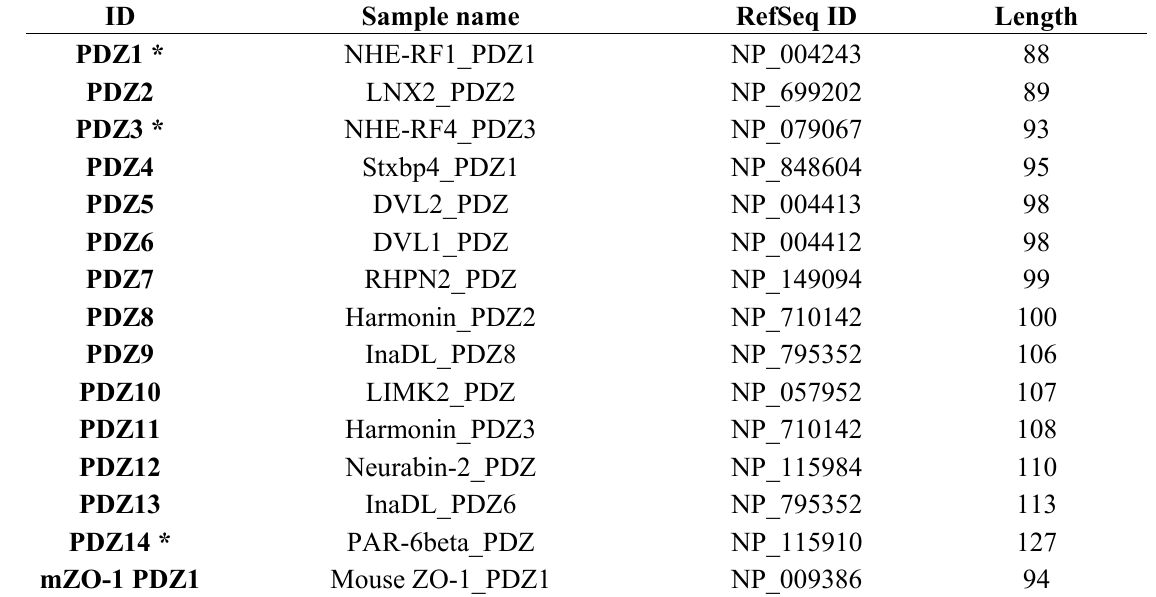
Table 1. PDZ domains used in this study.